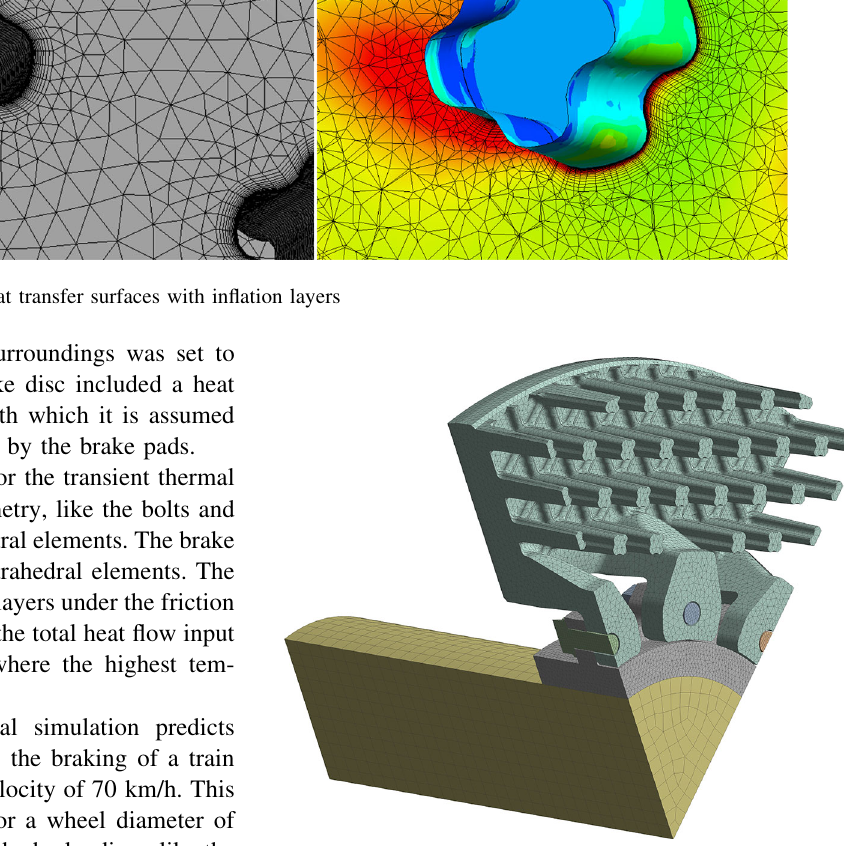
Fig. 4 Numerical mesh used for transient thermal analysis